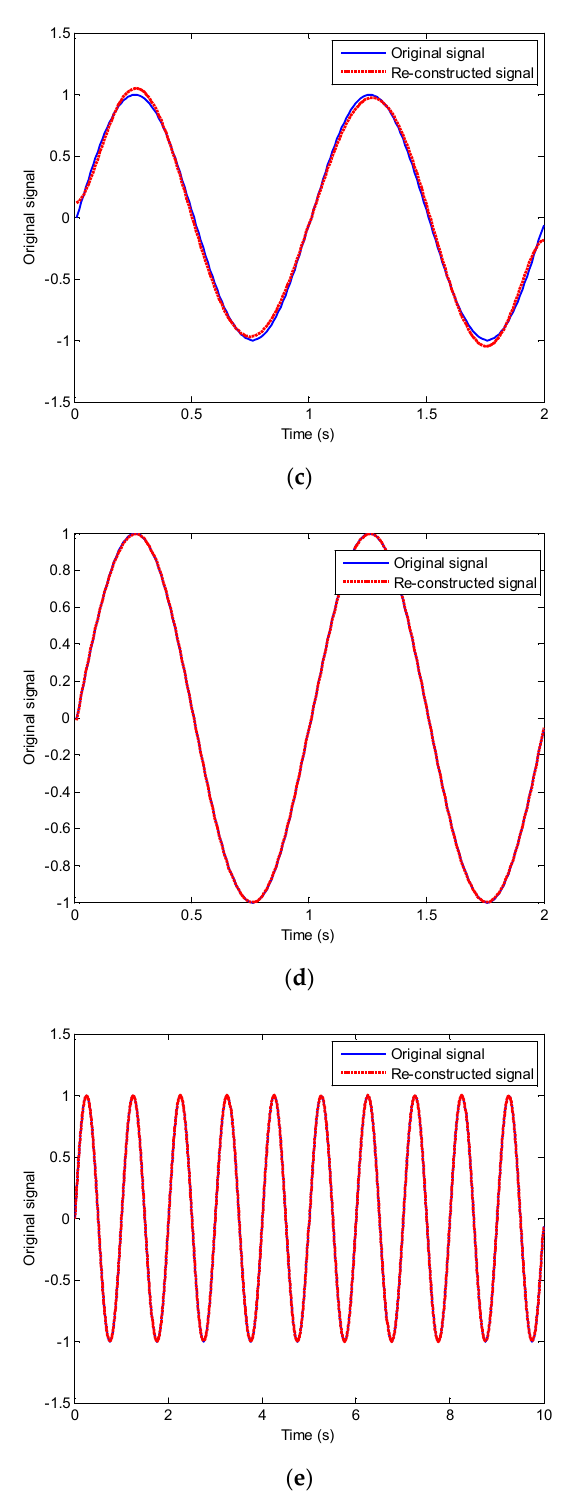
Figure 2. Re-construction of single frequency signals with Chebyshev polynomial. ( a ) Re-construction with first five terms of Chebyshev polynomial. ( b ) Re-construction with first six terms of Chebyshev polynomial. ( c ) Re-construction with first nine terms of Chebyshev polynomial. ( d ) Re-construction with first ten terms of Chebyshev polynomial. ( e ) Re-construction with first forty terms of Chebyshev